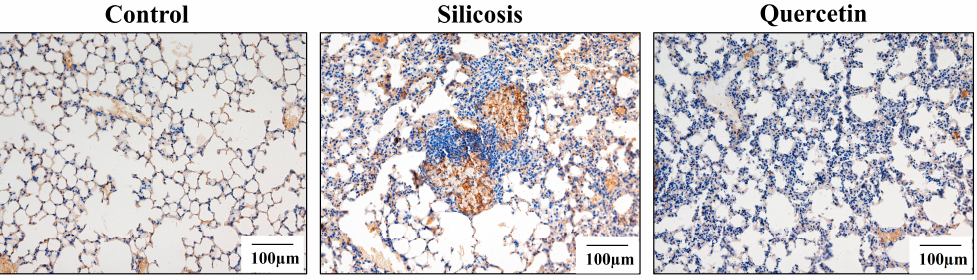
Figure 5. The expression of α -SMA in the lungs, measured by immunohistochemical staining (scale bar = 100 µm).